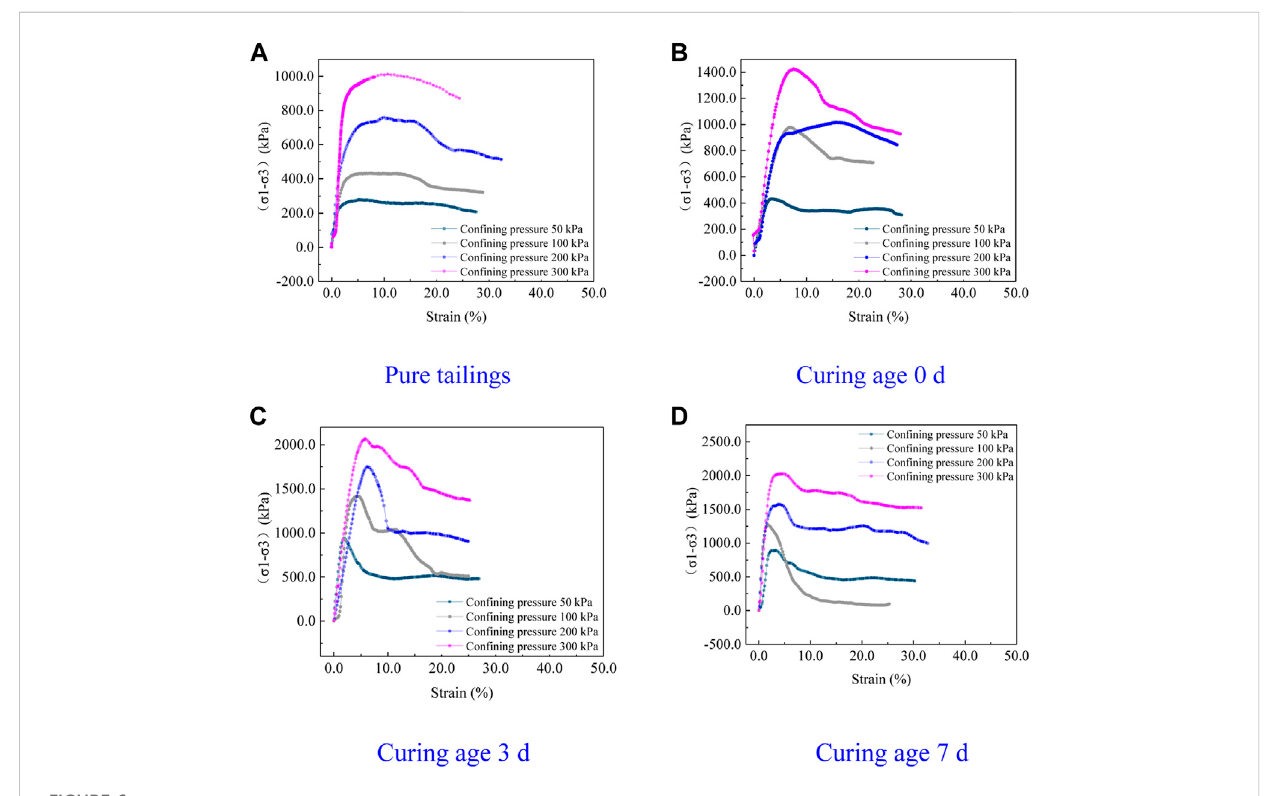
FIGURE 6 Stress-axial strain of different curing age